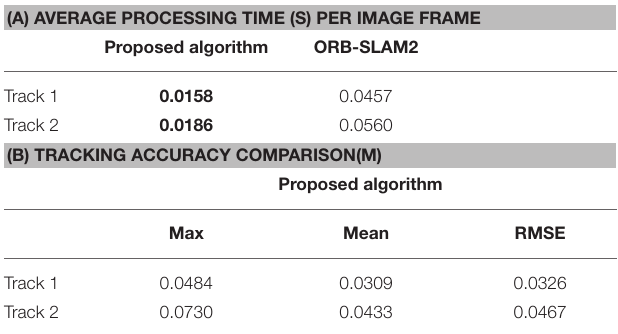
TABLE 4 | The performance comparison of the tracking algorithms. (A) AVERAGE PROCESSING TIME (S) PER IMAGE